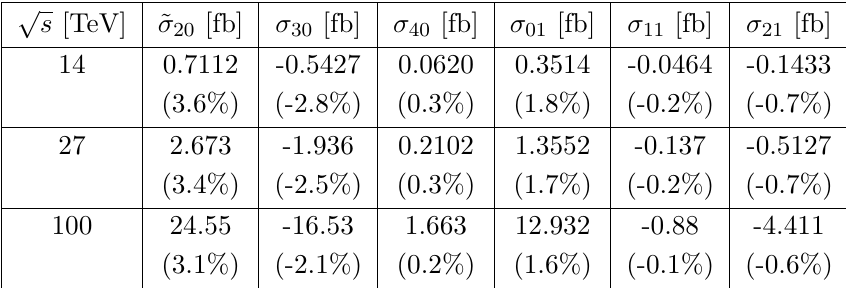
Table 2 . Two-loop contributions to (cid:27) pheno same